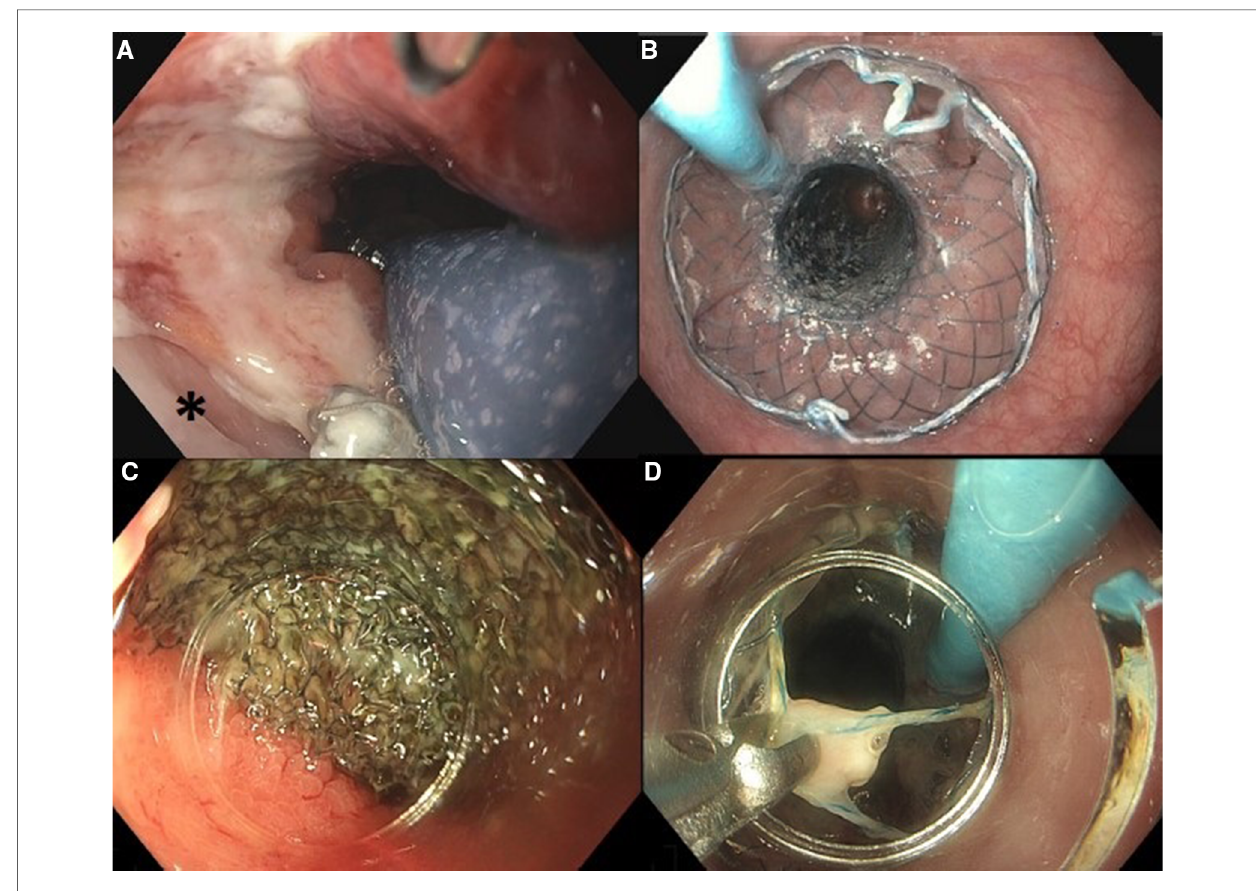
FIGURE 1 Placement of VACStent: ( A ) positioning of the sponge part of the VACStent over the defect (*). ( B ) Deployed VACStent. Removal of VACStent: ( C ) Separation of VACStent from mucosa using a tapered hood distal attachment cap. ( D ) VACStent removal using grasping forceps.